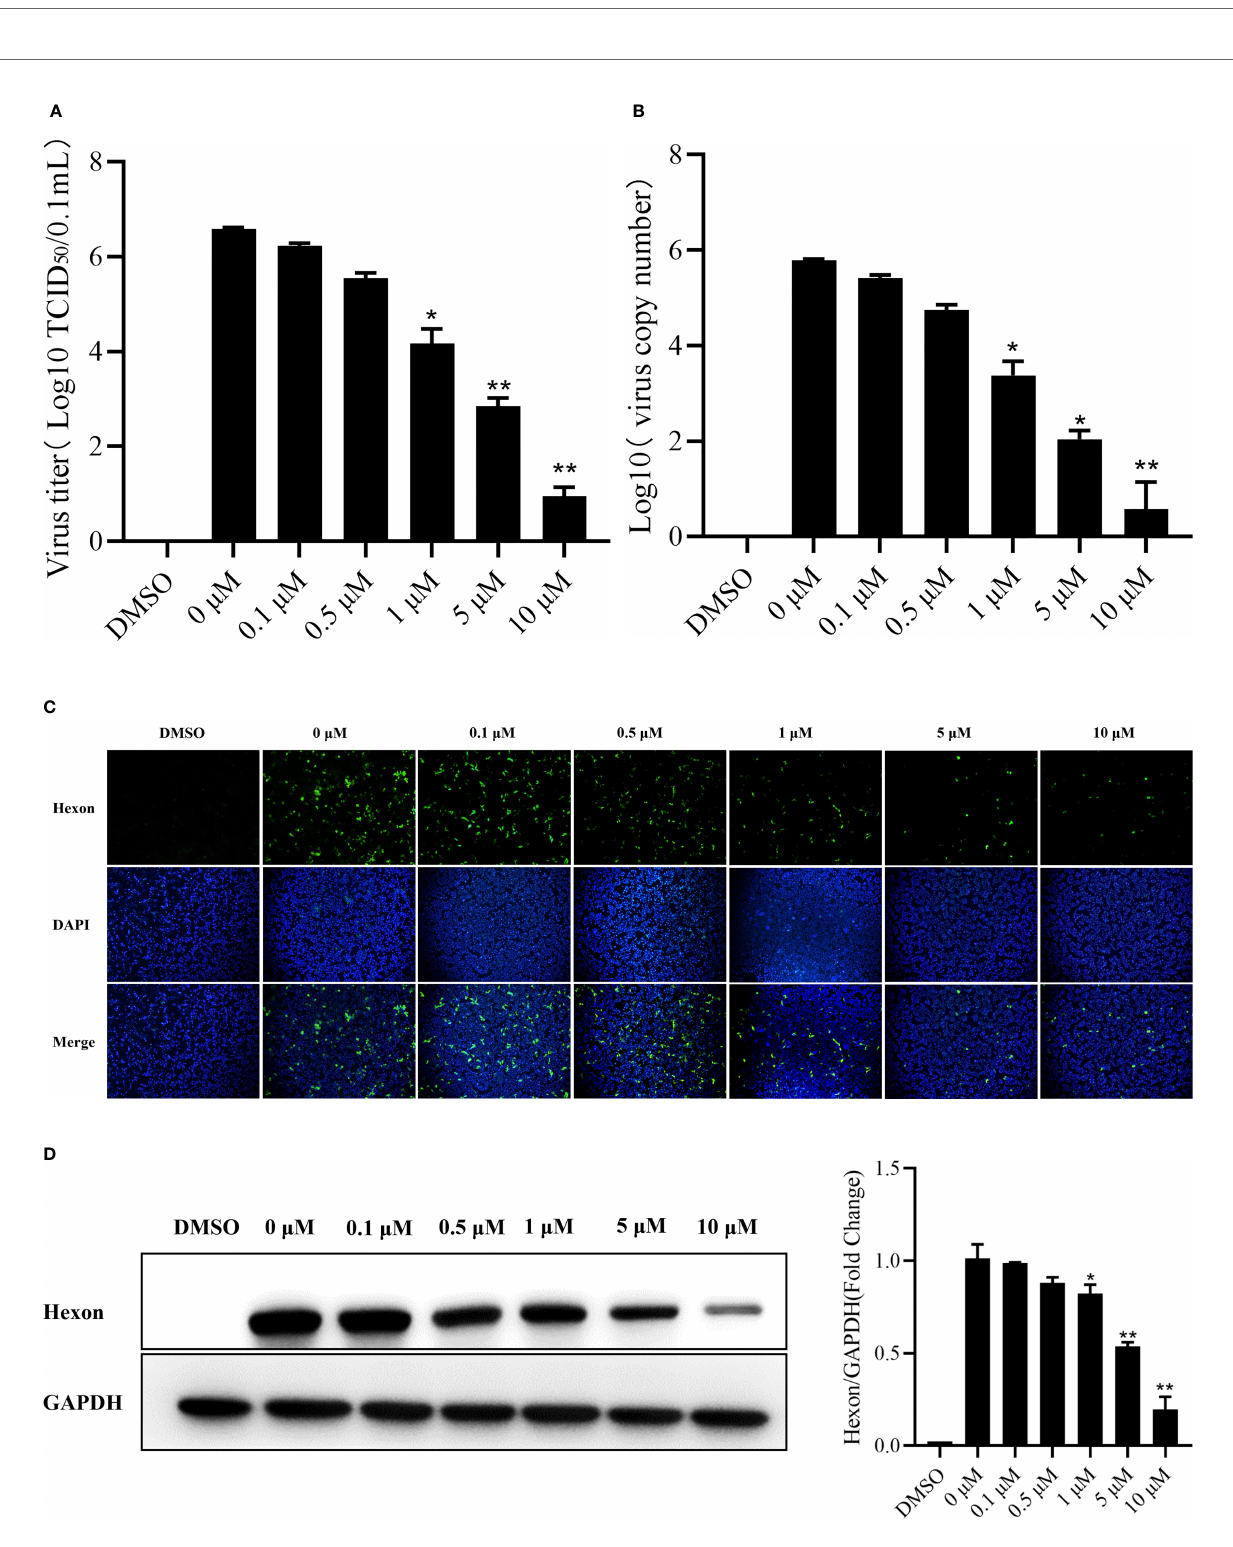
FIGURE 2 | Dose-dependent inhibition of FAdV-4 infection by camptothecin. LMH cells were treated with different concentrations of camptothecin (0 m M, 0.1 m M, 0.5 m M, 1 m M, 5 m M, and 10 m M) at 37°C and subsequently infected with FAdV-4 at an MOI of 1 for 48 h (A) Virus titers were determined by measuring the TCID 50 assay. (B) Virus copy numbers were quanti fi ed by qPCR. (C) FAdV-4 Hexon protein expression in LMH cells was detected using indirect immuno fl uorescence staining. (D) FAdV-4 Hexon protein expression in cells was detected using Western blot analysis. All experiments were performed in triplicate ( n = 3). Error bars represent the standard deviation. The asterisks in the fi gures indicate signi fi cant differences (* P < 0.05; ** P <